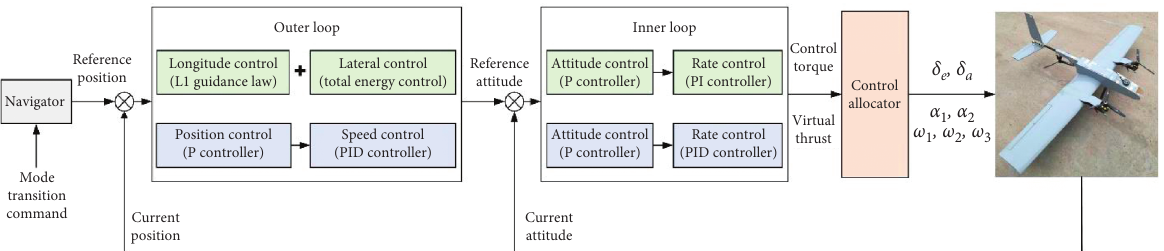
Figure 9: Block diagram of the control